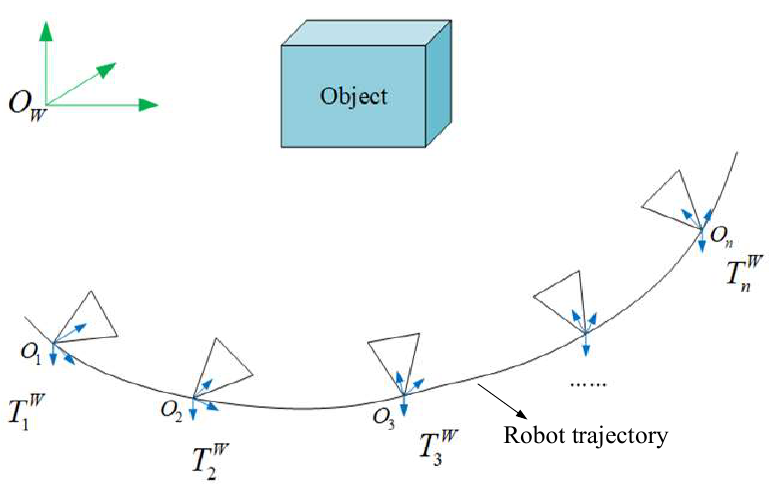
Figure 3. Schematic diagram of the observed object from different views.